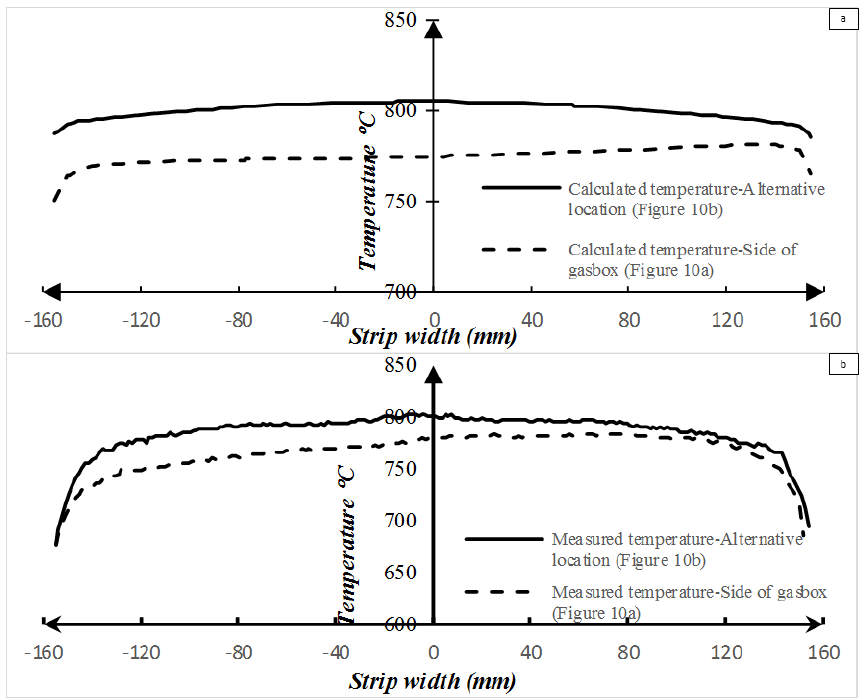
Figure 11. Comparison between the different position of the hydrogen gas inlet, ( a ) calculated temperatures, and ( b ) measured temperatures by using the IR-camera, ε = 0.4. Strip velocity = v Strip (< 0.17 m/s) .